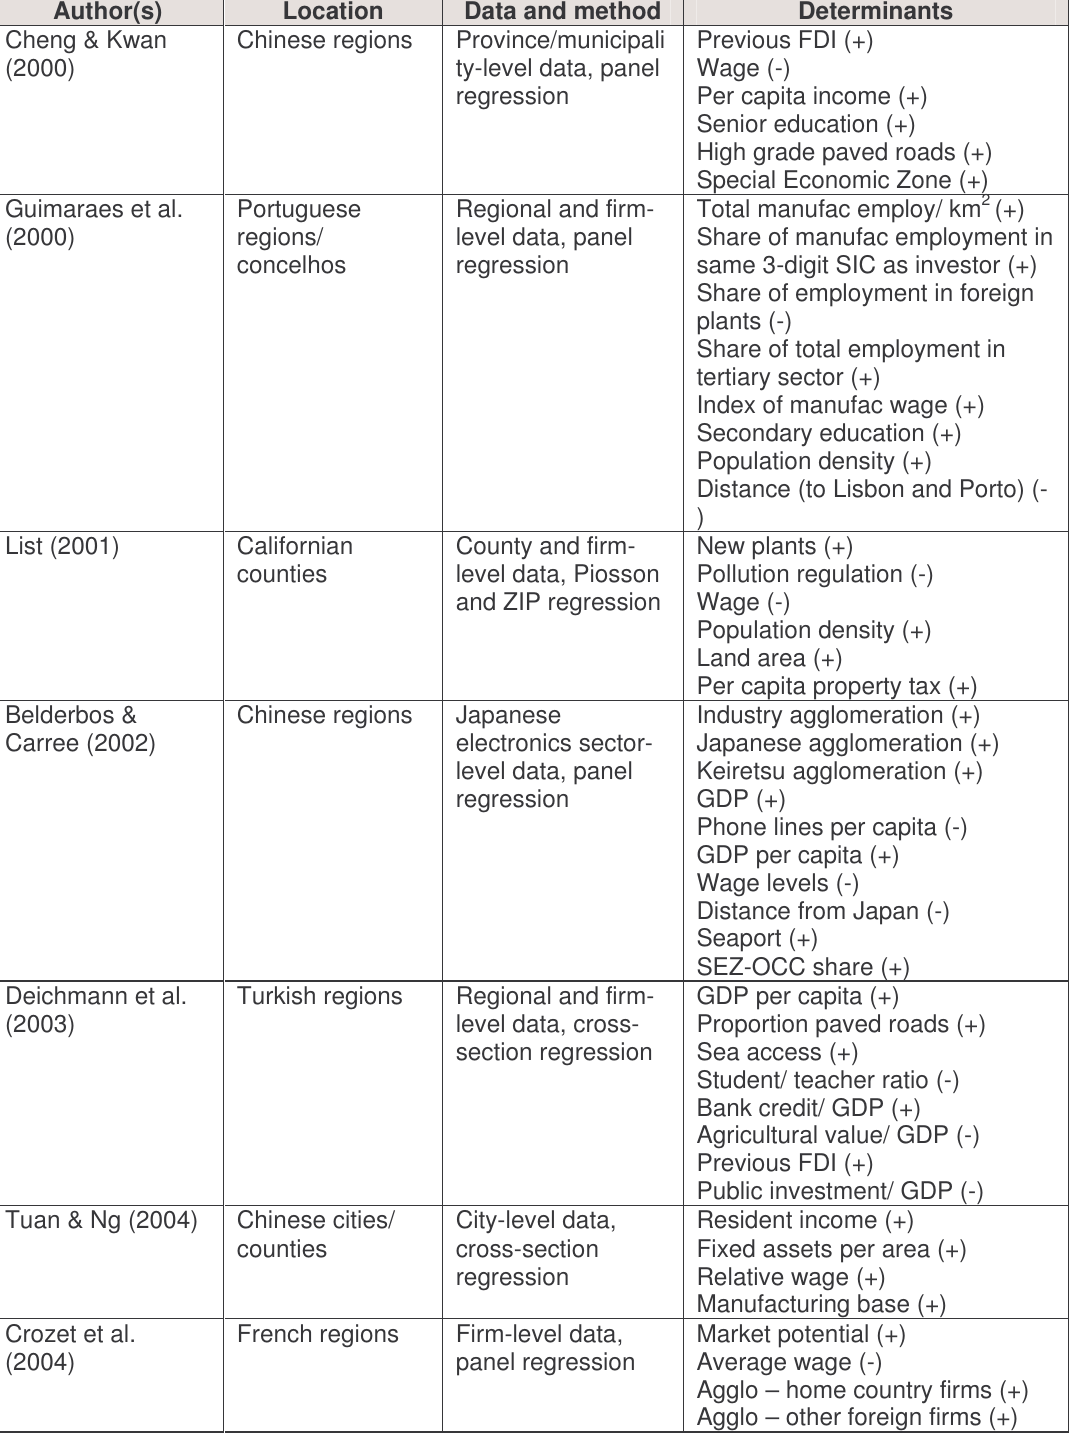
Table A: Summary of recent